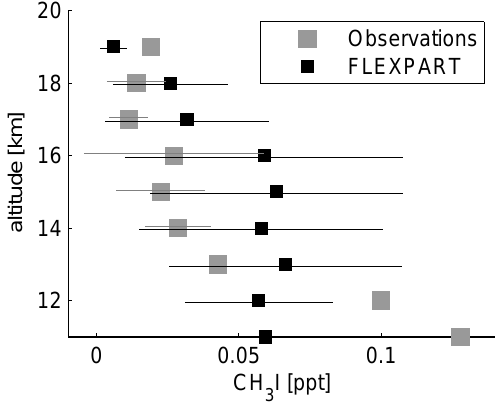
Fig. 9. Comparison between observed and modeled vertical pro- files of CH 3 I in the upper troposphere and TTL. Observations and model results are averaged over all data campaign-averaged profiles that include measurements in the upper TTL (ACCENT, Pre-AVE, TC4-WB57, and ATTREX). Horizontal bars indicate ± 1 standard